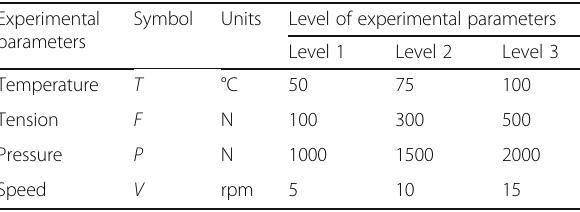
Table 1 Level of process parameters Experimental